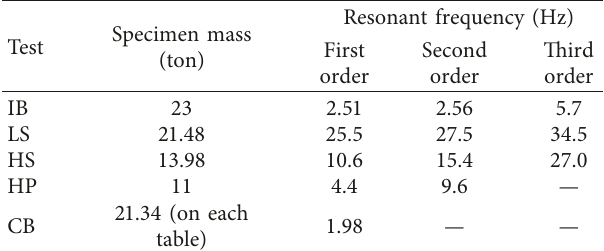
Table 3: Mass and resonant frequency of five specimens.